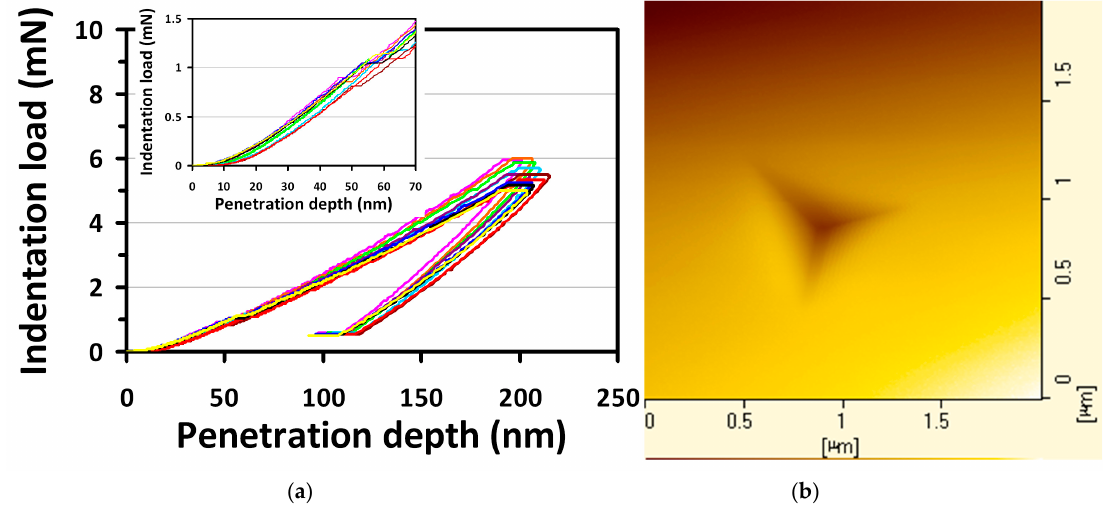
Figure 1. ( a ) Ten contact sti ff ness measurements (CSM) load-displacement curves show the “pop-in” events of GaP(100) single-crystal during nanoindentation. Insert: zoom in the range of penetration depth (0–70 nm) and indentation load (0–1.5 mN). ( b ) AFM image of the nanoindentation.